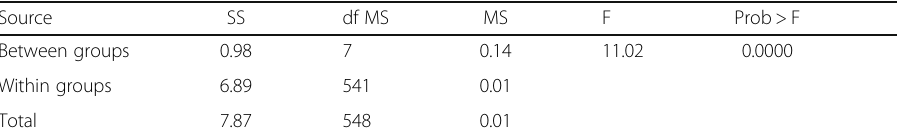
Table 3 One-way ANOVA results for expectation scores